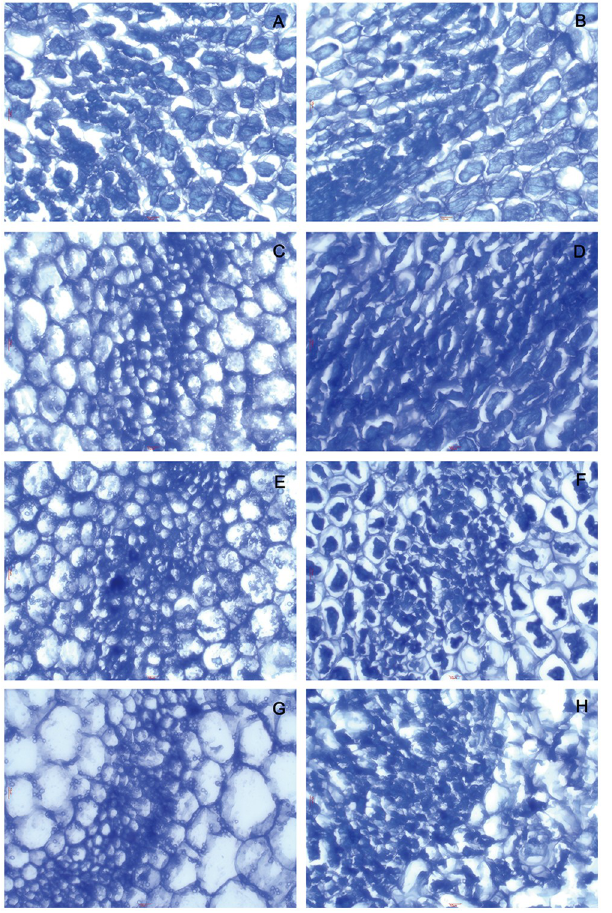
Fig 3. Toluidine blue staining of mung bean hypocotyls in different preimbibition and dehydration states. A, C, E and G show the transverse sections of the hypocotyl with 3, 6, 18 and 24 h of preimbibition, respectively. B, D, F and H show the transverse sections of the hypocotyl with 3, 6, 18 and 24 h of preimbibition after 24 h of dehydration,